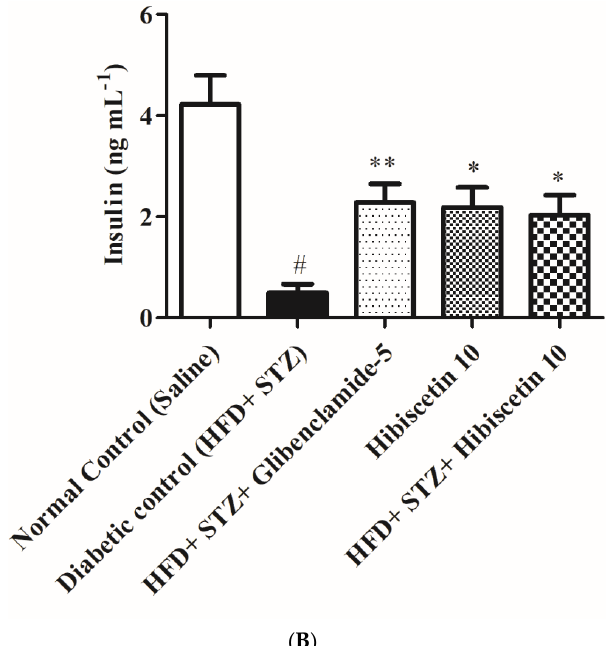
Figure 2. ( A , B ) Effect of hibiscetin on blood glucose ( A ) and insulin ( B ) (n = 6). The mean SEM is used to express the data; ( # p < 0.05) saline vs. HFD+STZ; (** p < 0.01, and * p <0.05) HFD+STZ vs. treatment group.